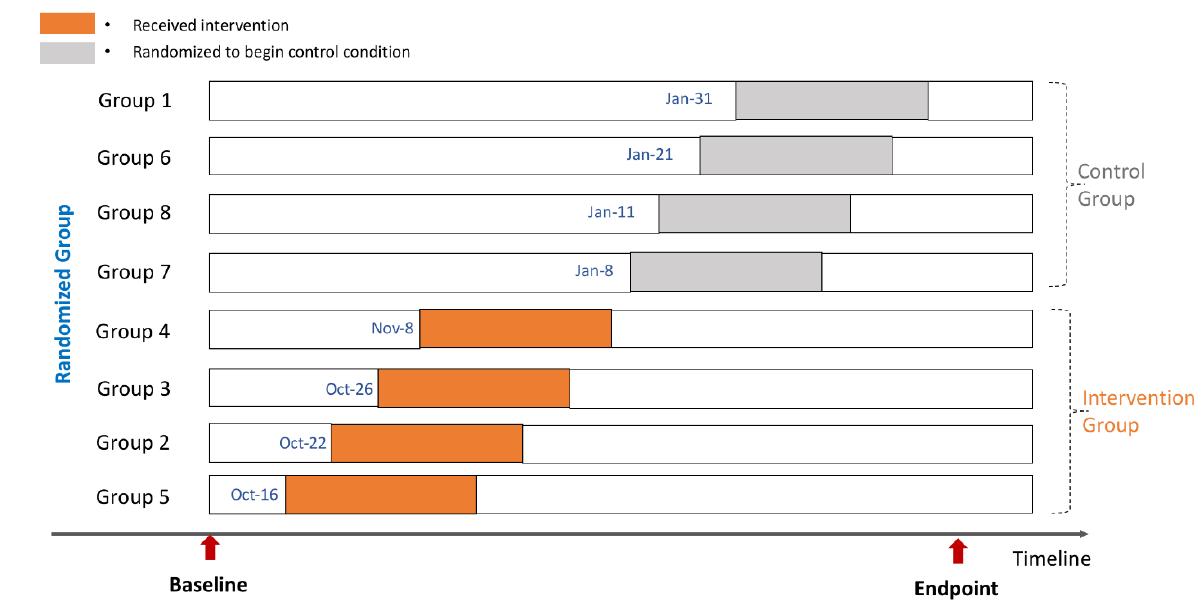
Figure 2. Study data